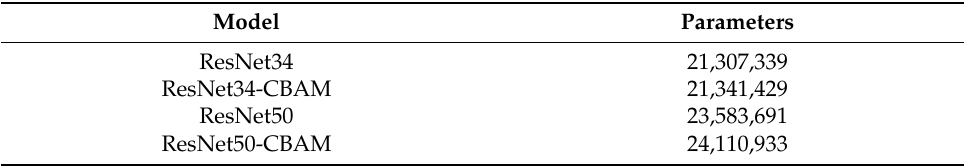
Table 1. Comparison of parameters of four ResNet models.